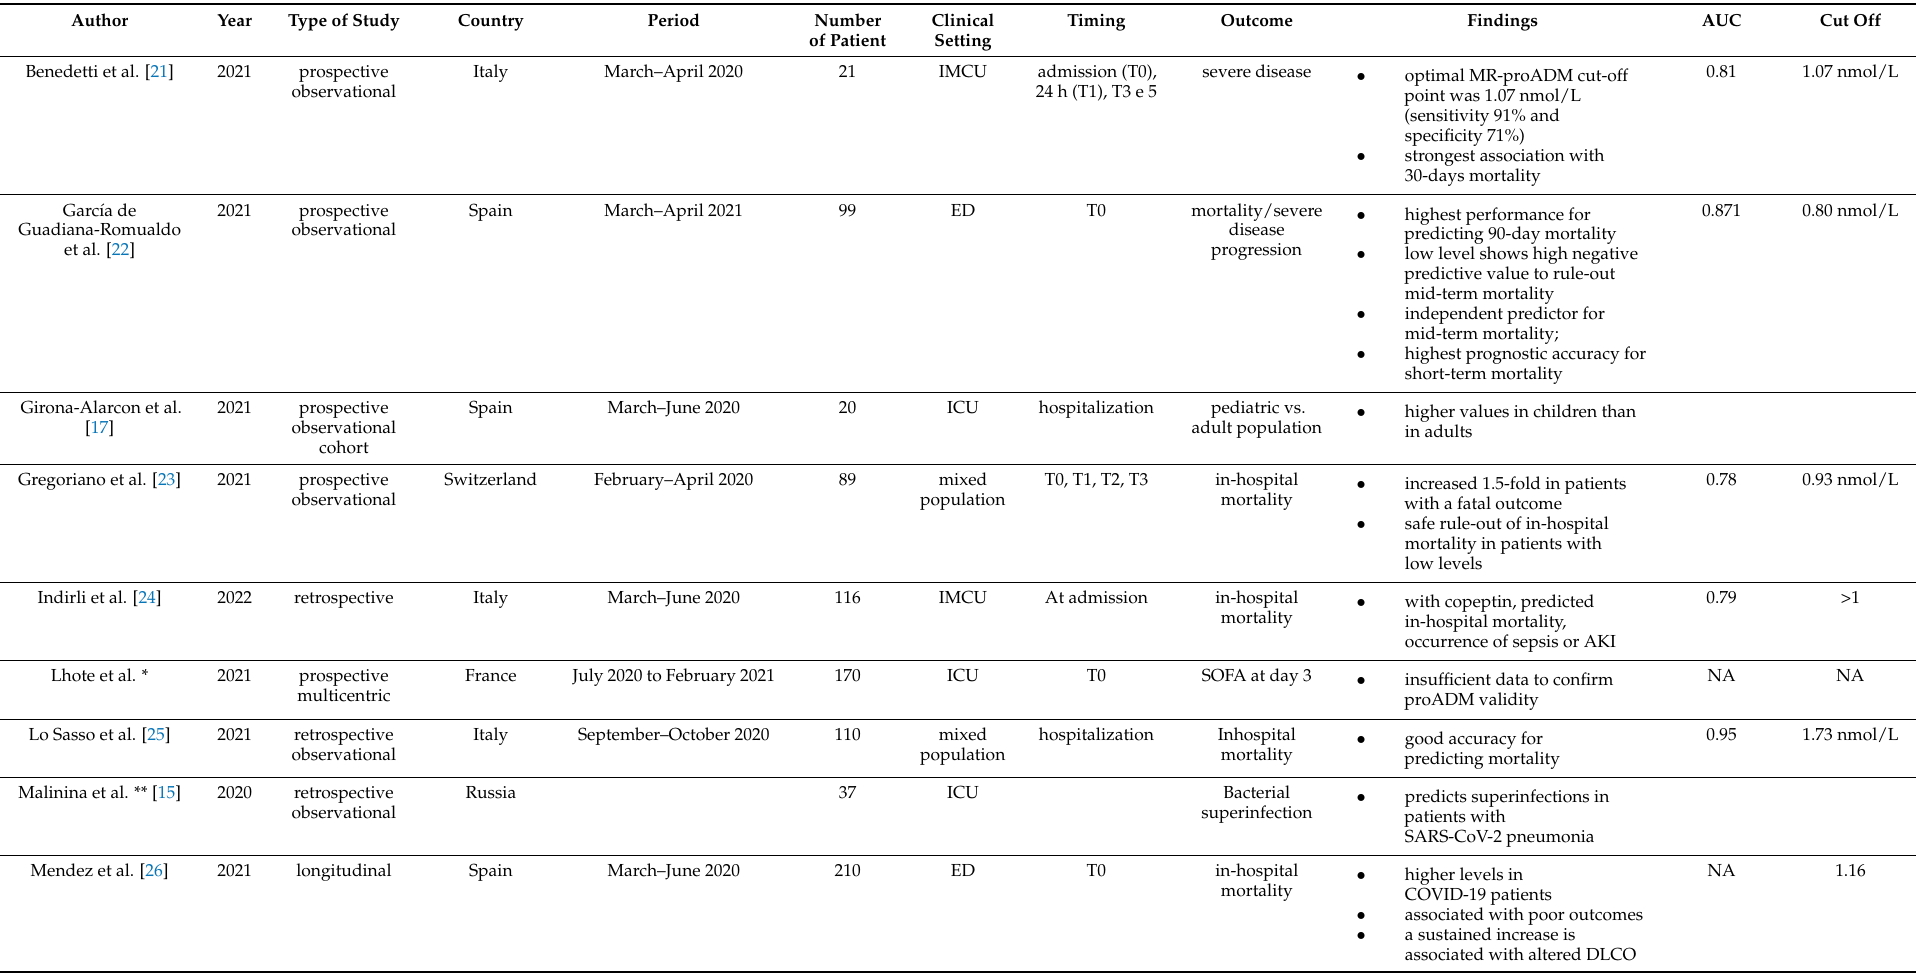
Table 1. Descriptive table of systematic review results, including the 20 full texts